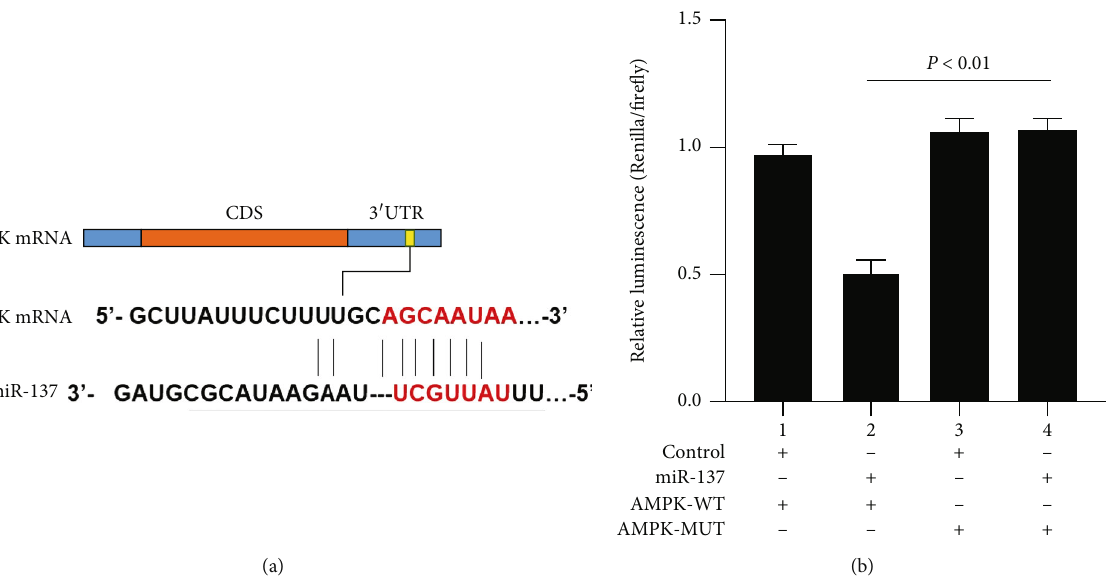
Figure 3: Targeted regulation of AMPK by miR-137. (a) Schematic diagram of miR-137 ’ s binding sites in AMPK 3 ′ -UTR; (b) DLR gene assay. Each test ran in triplicates. The means were pairwisely compared using Student ’ s t -test. P < 0 : 01 means the presence of statistical signi fi